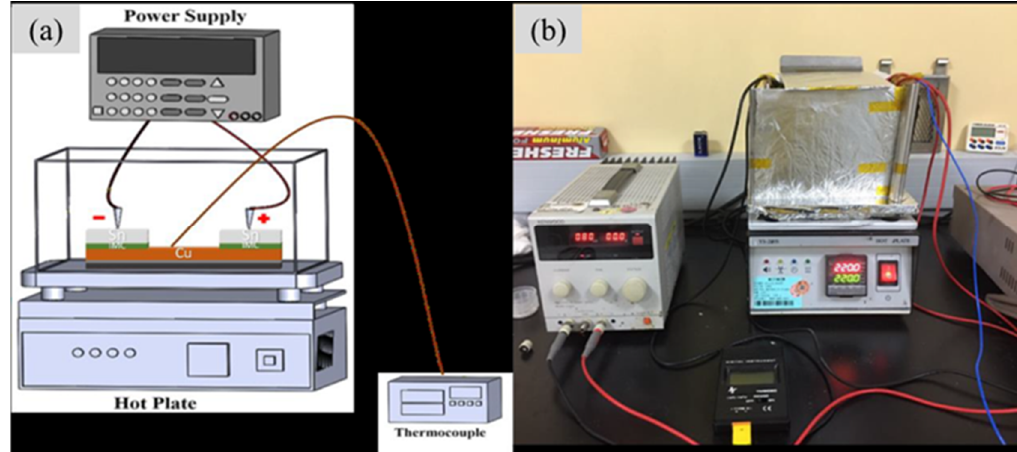
Figure 4. Thermal annealing test. ( a ) Structure diagram of heating and input current test; ( b ) experimental schematic diagram of heating and input current testing.